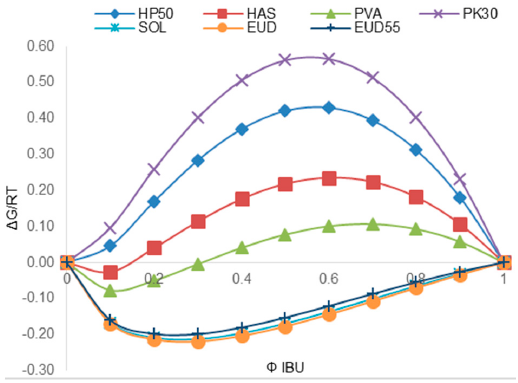
Figure 3. Phase diagram derived from δ (F) estimation at 25 °C for mixtures of IBU and PK30, HP50, HAS, PVA, EUD55, SOL, and EUD (from top to bottom).